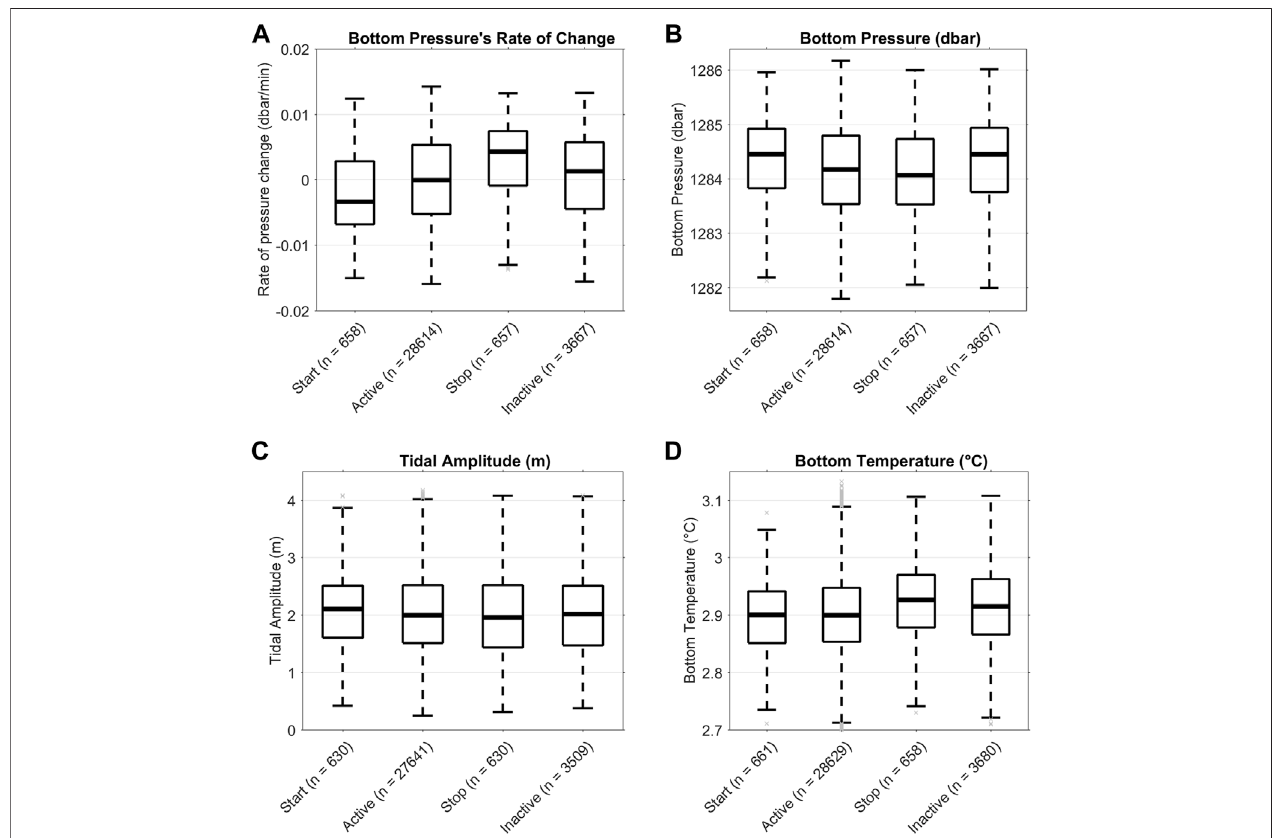
FIGURE5| Boxplotsshowingthedistributionofventingstatesinrelationto (A) therateofbottompressurechange,whichrepresentstherateoftidalrise/fall (B) the bottom pressure, (C) tidal amplitude, and (D) the bottom temperature. Inactive times and venting onsets are slightly more common at higher pressures than at lower pressures. The boxes representthe interquartile range (IQR), thatis, the distancebetweenthe 25th percentile (q 1 ) and the 75th percentile (q 3 ).The solid linein the box is the median. The whiskers (dashed lines) show the full range of the dataset excluding any outlier. The grey crosses show the outliers. Points are shown as outliers if they are smaller than q 1 − 1.5 IQR or larger than q 3 + 1.5 IQR.